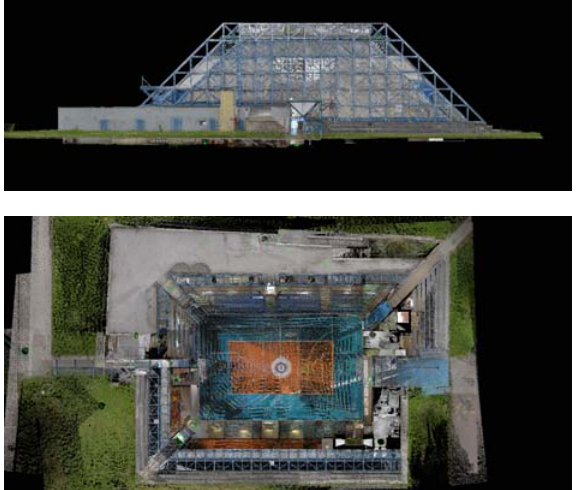
Figure 4 . The state of deterioration of the good.